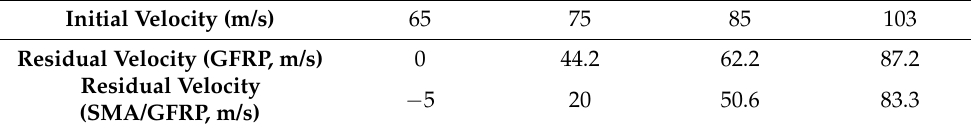
Table 5. Comparison of residual velocities for GFRP and SMA/GFRP impact